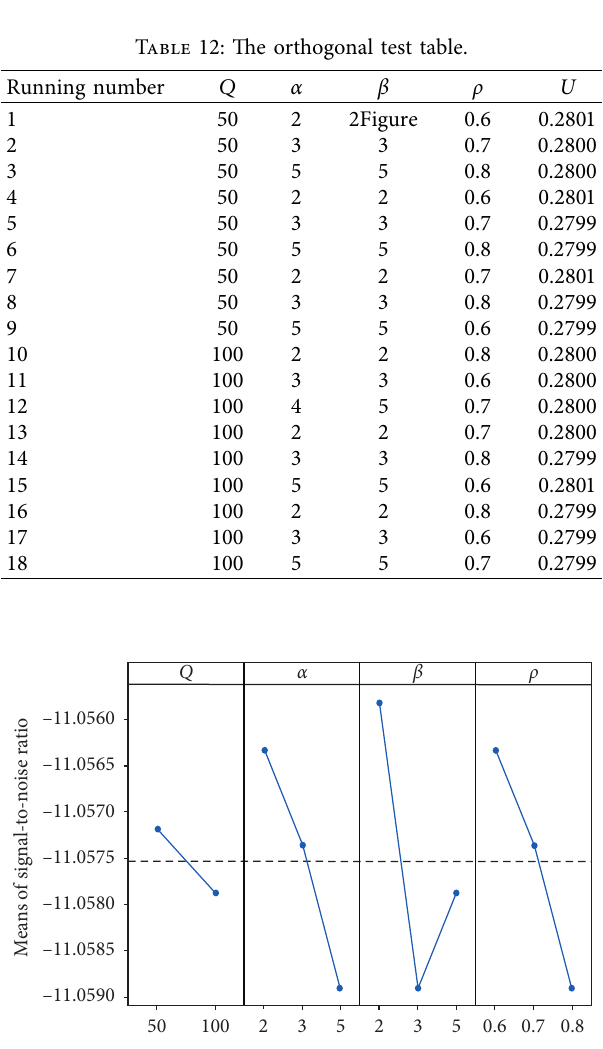
Figure 7: Signal-to-noise ratio main effect diagram.